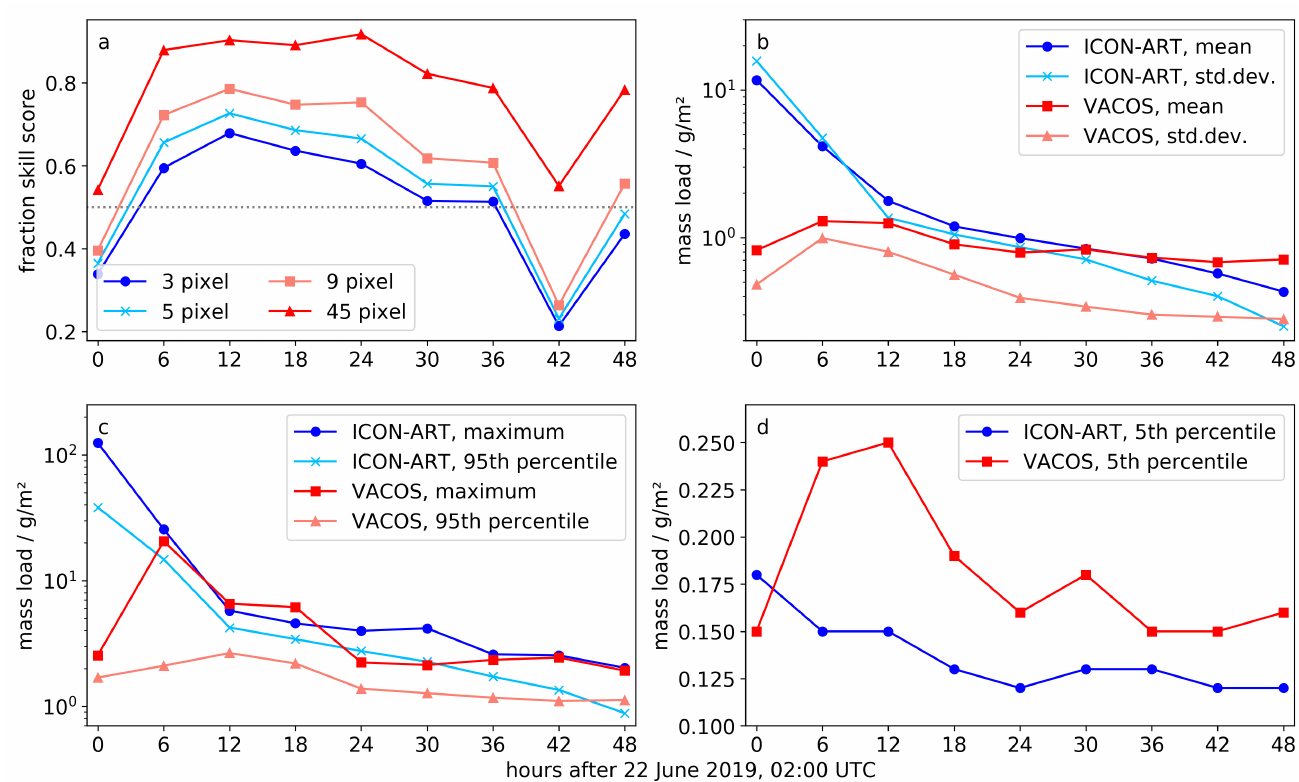
Figure 7. Comparison of volcanic ash cloud data retrieved from VACOS from Himawari-8/AHI using moderate SBAFs and simulated with ICON-ART for the Raikoke eruption from 22 June 2019, 02:00 UTC to 24 June 2019, 02:00 UTC. ( a ) The fraction skill score using kernels of 3–45 pixels. ( b ) Mean and standard deviations for the volcanic ash mass loads. ( c ) Maximum and 95th percentile for the volcanic ash mass loads. ( d ) The 5th percentile for the volcanic ash mass loads. See text for